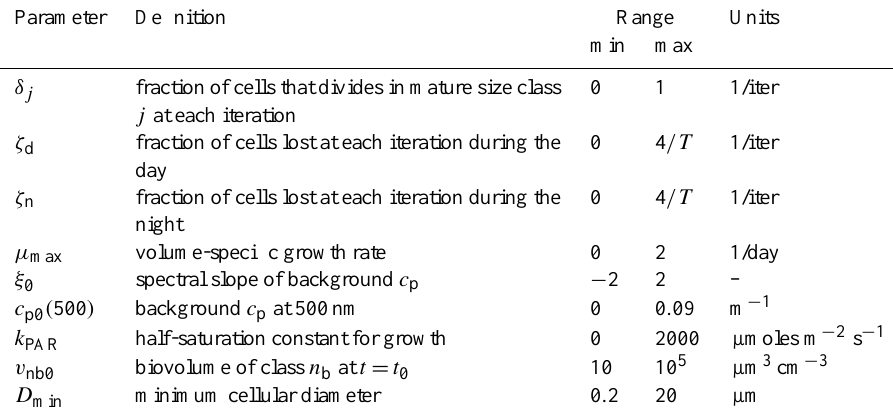
Table 2. Definitions, ranges and units of optimized model parameters. Parameter Definition